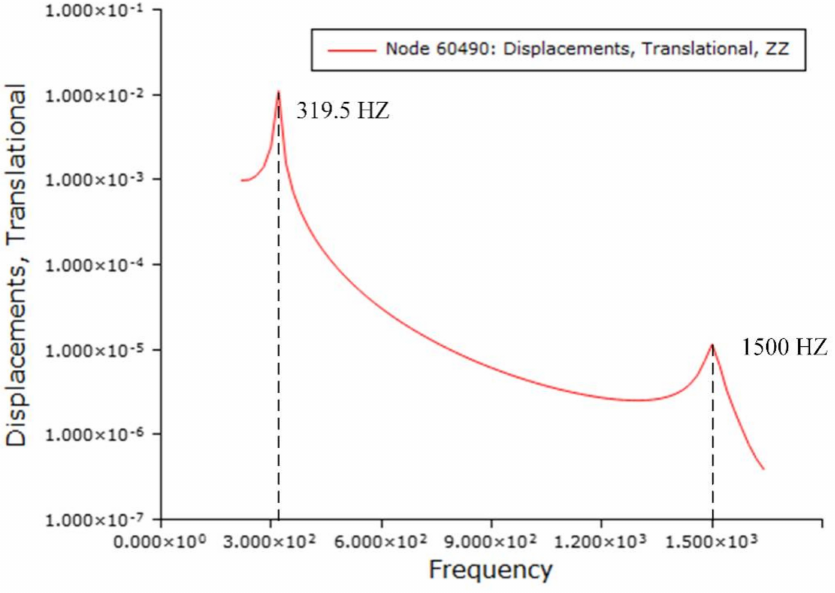
Figure 6. Frequency response curve of the primary